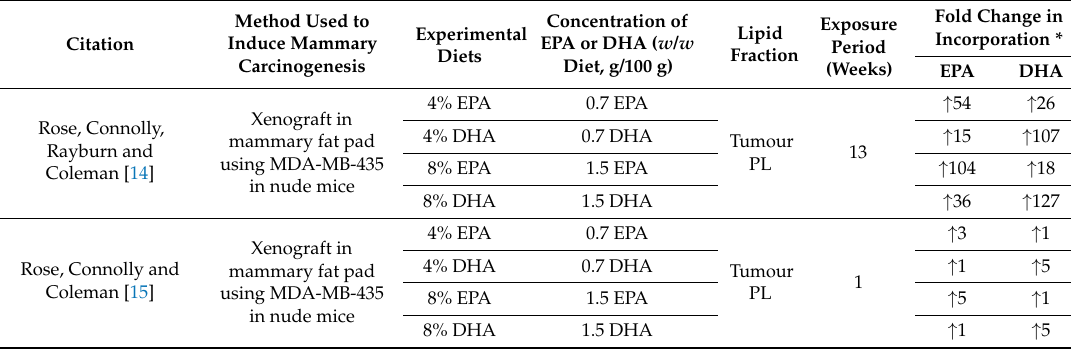
Table 4. Incorporation of EPA and DHA measured in the plasma membrane when comparing EPA to DHA in rodent models of human